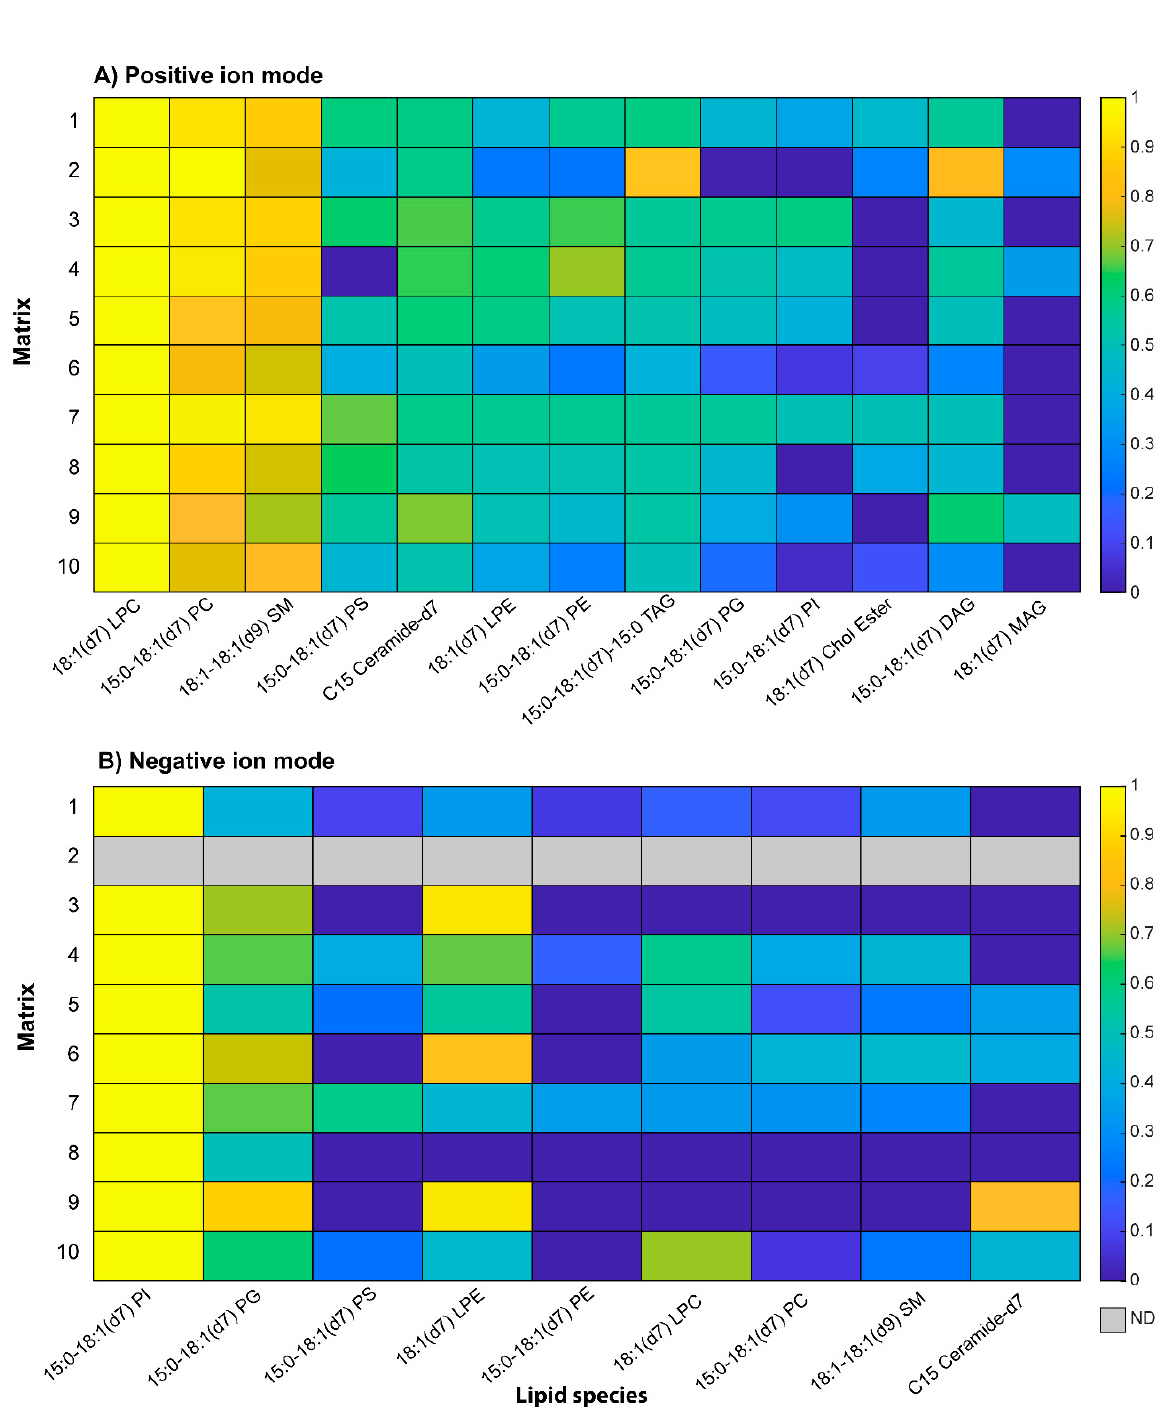
Figure 6. Heatmap plots in logarithmic scale showing the normalized average intensity of each compound mixed with each matrix in positive ( upper panel ) and negative ion mode ( lower panel ). In positive ion mode, the intensities are the sum of sodium and protonated adducts. For TAG, DAG, MAG, PG, and PI, the protonated adduct was not observed regardless of the matrix used, while the sodium adduct was observed for all lipids. In negative ion mode, the deprotonated molecules were considered for PE, LPE, PG, PI, PS, and Cer, while the demethylated species were considered for PC, LPC, and SM. TAG, DAG, MAG, and CholEst do not ionize in negative modality. The color scale index goes from the highest (yellow) to the lowest (blue) intensity.